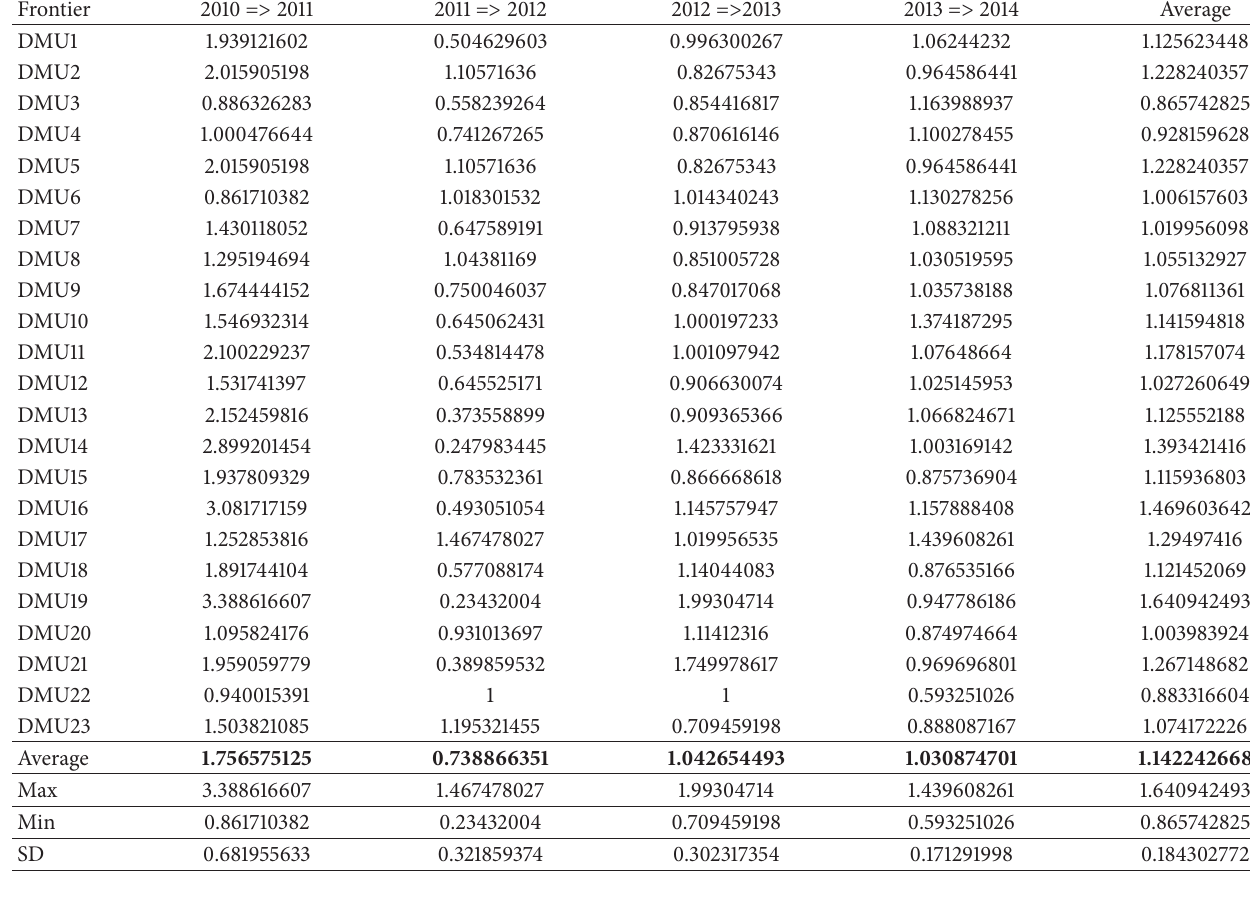
Table 14: Technical (Frontier) change over the period 2010 to 2014.